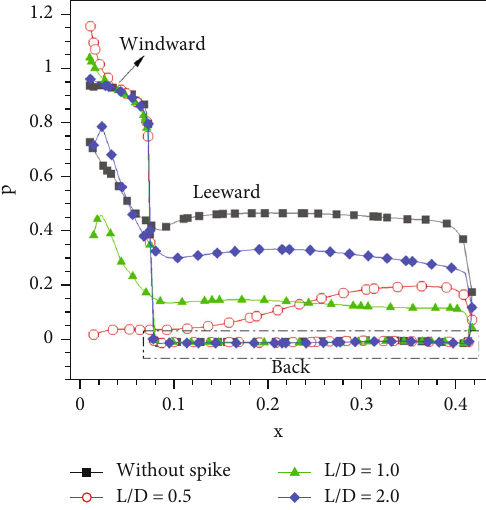
Figure 11: Wall pressure distribution of a blunt body at a pitch angle of 20 °